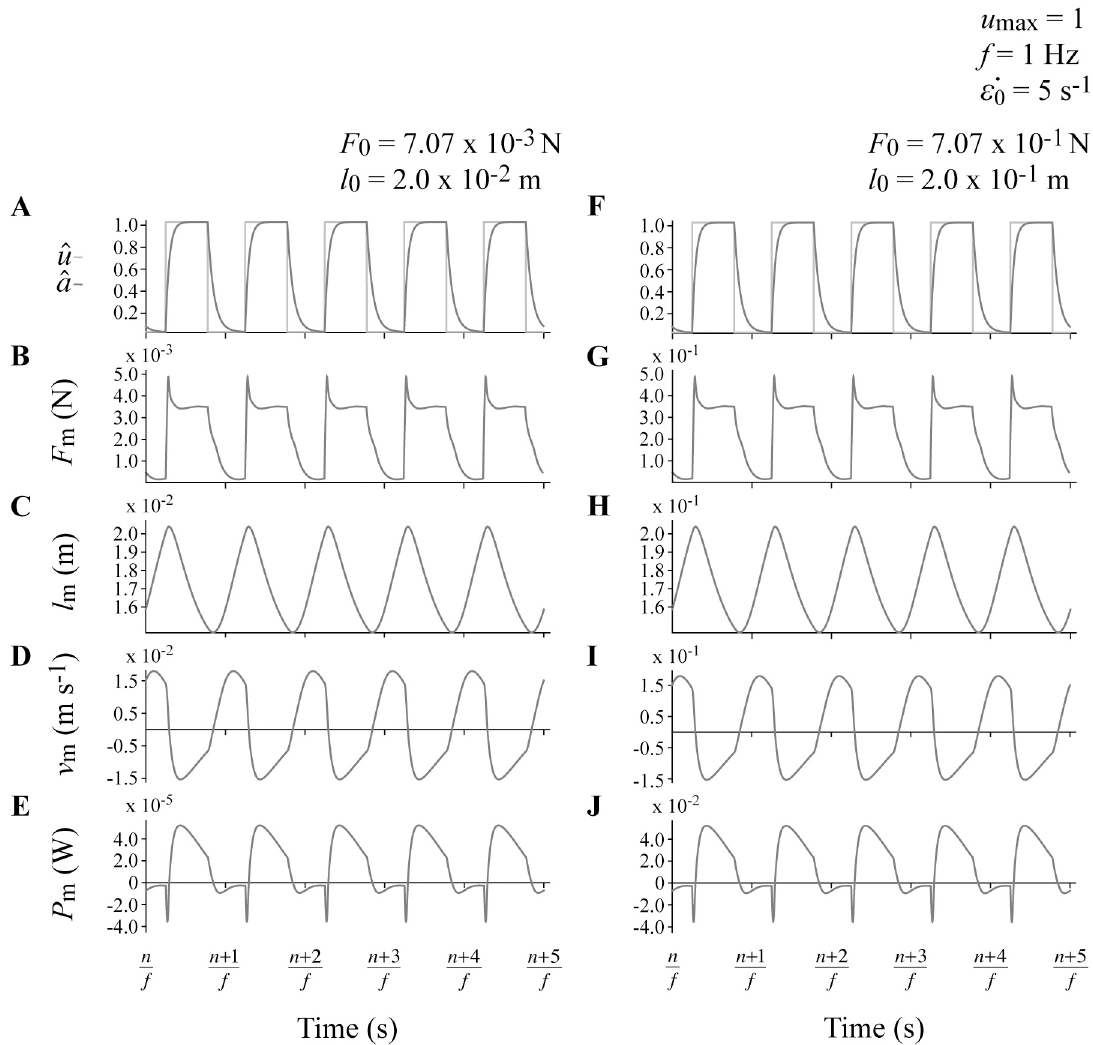
Fig 3. Sample raw output traces. Muscle excitation and activation (A,F), force (B,G), length (C,H), velocity (D,I) and power (E,J) traces for two representative simulations with u max of 1, f of 1 Hz, _ ε